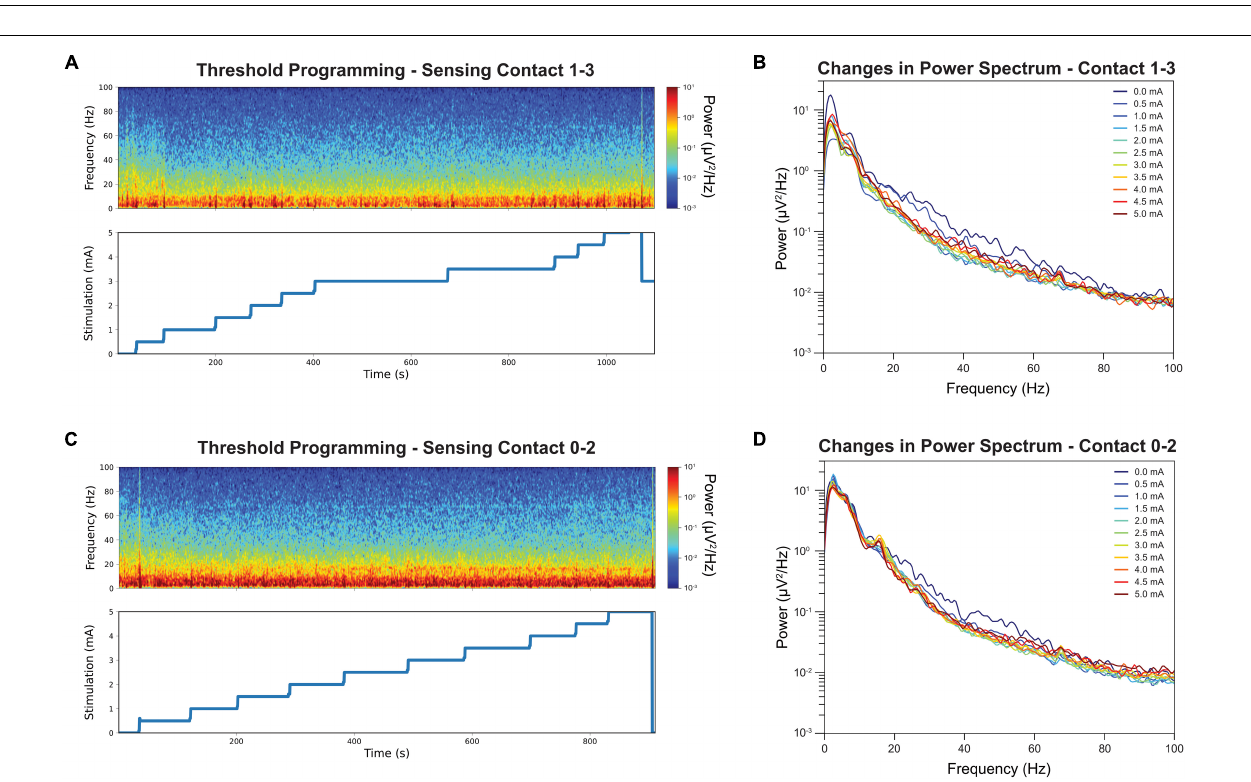
FIGURE 2 | Time-frequency analysis during stimulation threshold testing and their corresponding stimulation amplitude is displayed. Note the stimulation amplitudes are up to but not exceedings the side-effect threshold for stimulation contact 2 (A) . The color denotes the absolute power at each time point, with the red indicating strongest power and the blue lowest. Sensing contact 1–3 revealed a reduction of power in the beta band in spectrogram when the stimulation amplitude was increased. The average power spectrum at each stimulation amplitude for stimulation contact 2 (B) . Increased stimulation amplitude was associated with a decrease in beta band power. The same time-frequency analysis was repeated for contact 1 as comparison (C) . Increased stimulation amplitude was associate with a smaller decrease in beta band power (D) .